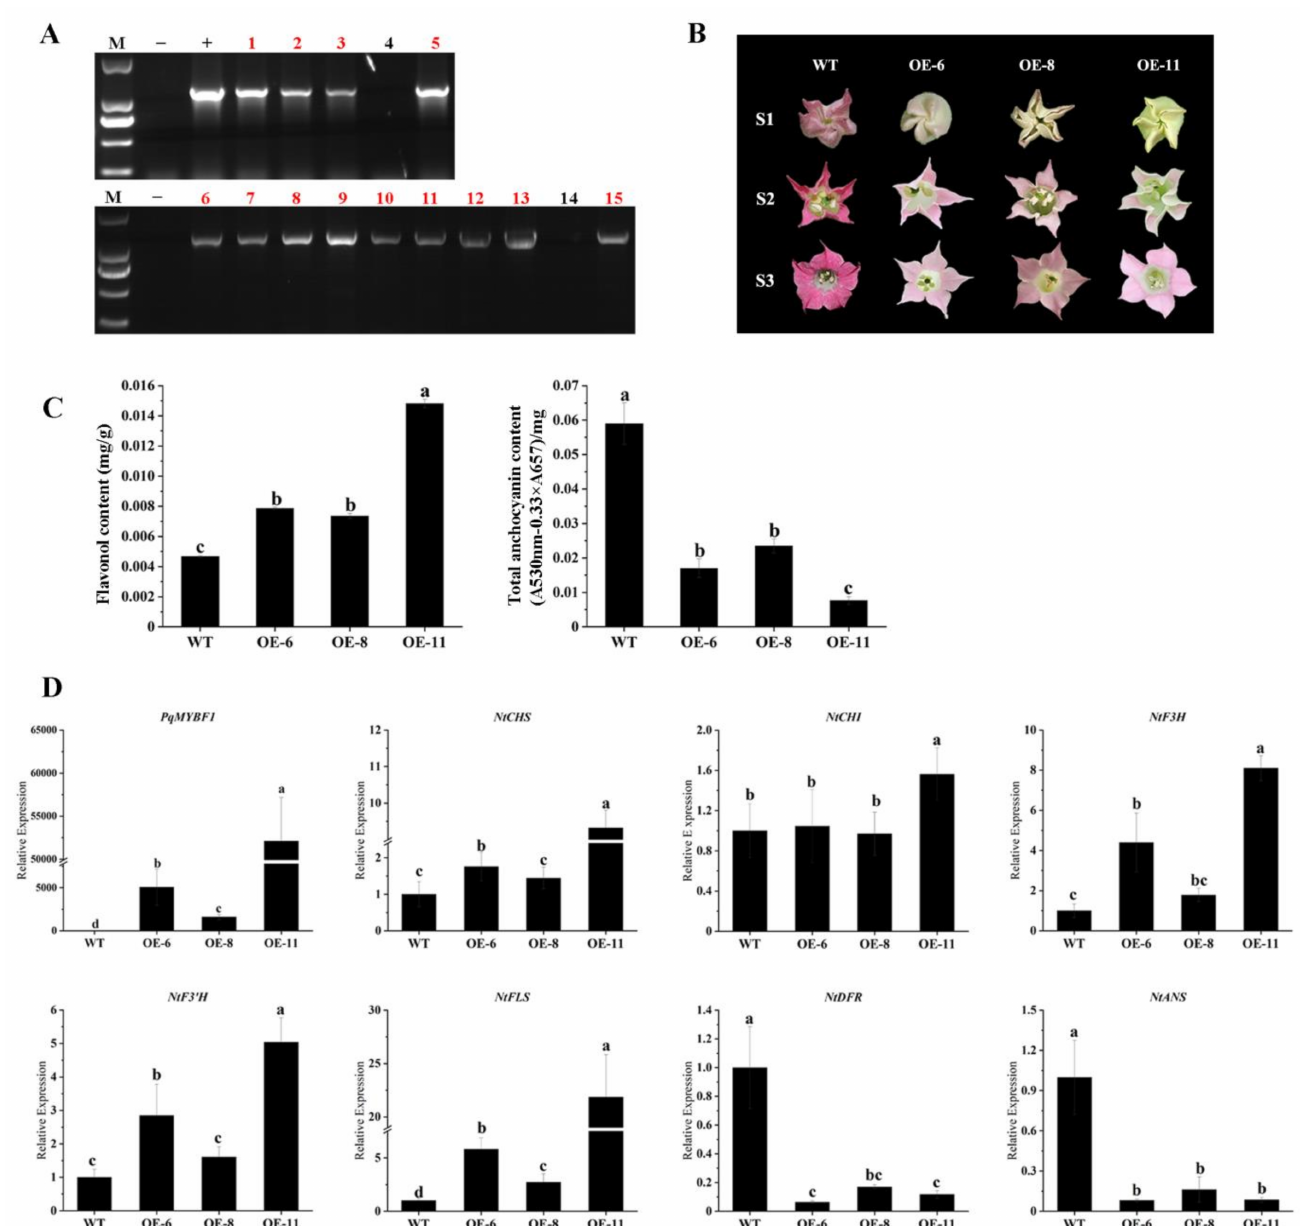
Figure 4. The phenotype and the effect of PqMYBF1 overexpression in transgenic tobacco. ( A ) PCR analysis of PqMYBF1 transformed tobaccos. M: Trans2K Plus DNA Marker; − : Negative control; +: Positive control; 1–15: PCR identification of tobacco; the red numbers indicate the transgenic tobaccos. ( B ) The petal phenotypes of transgenic and wild tobaccos at three flowering stages. S1: closed buds, S2: initially open flowers, S3: open flowers. ( C ) The anthocyanin and flavonol content in petals. ( D ) The expression profiles of vital anthocyanin and flavonol biosynthesis pathway genes in PqMYBF1 overexpression transgenic tobacco petals. a, b, c, and d indicate significant differences at the p ≤ 0.05 level in the Duncan